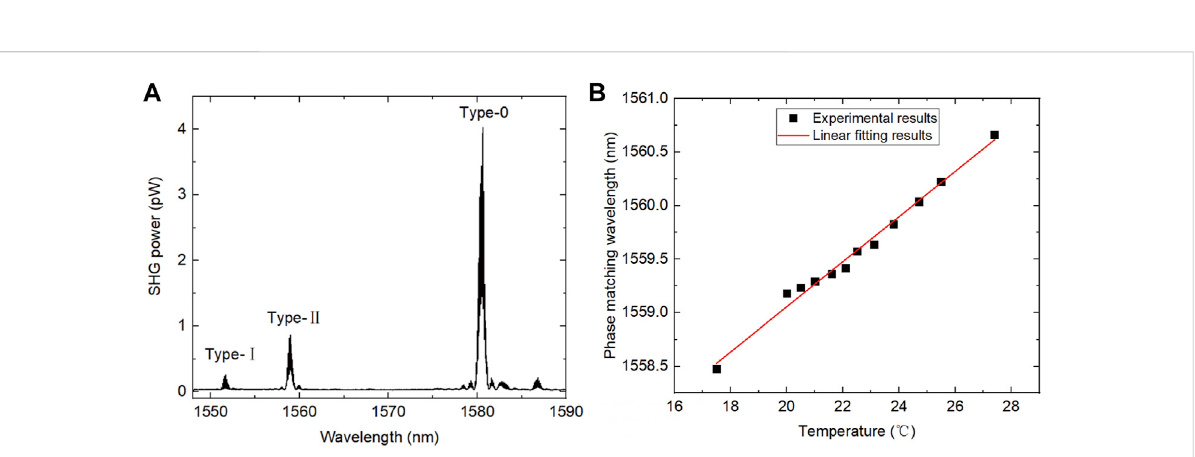
FIGURE 3 (A) The SHG tuning curves of the three PM schemes as a function of the FL wavelength. (B) The dependence of type-II PM wavelength on sample temperature. The line is a guide to the